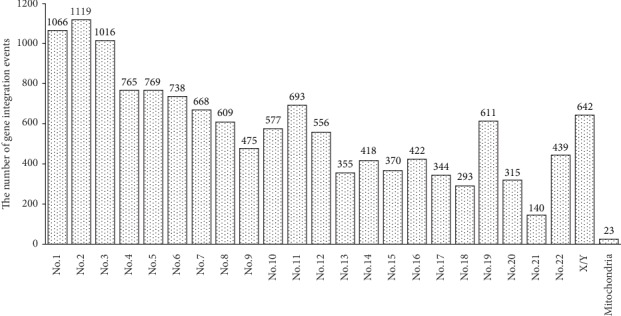
The number of HPV gene integration event in different human chromosomes.